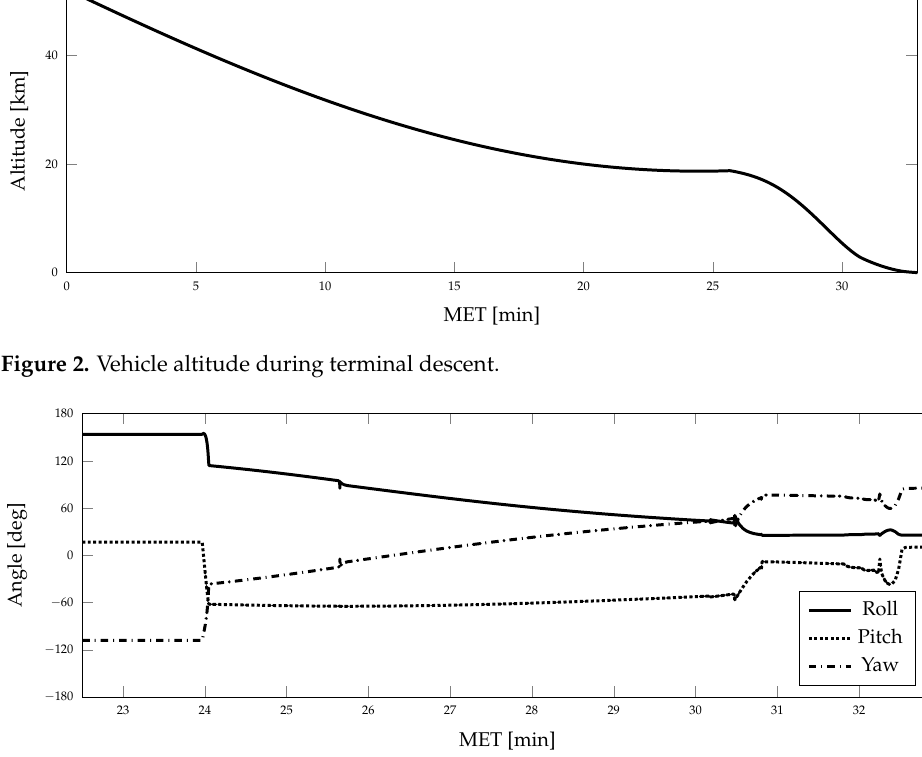
Figure 3. Vehicle attitude (Euler angles) during terminal descent states are assumed to be initially uncorrelated and sampled from Gaussian distributions, 288 with 1 σ uncertainties in each channel of position, velocity, and attitude shown in Table 1. 289